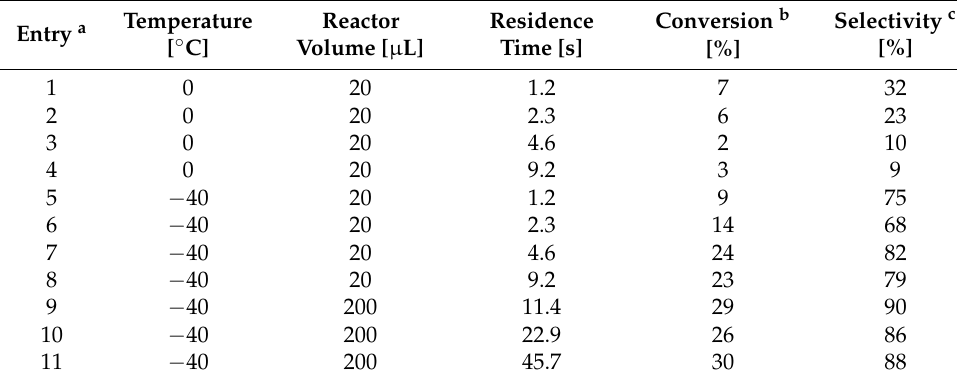
Table 1. Reduction using DIBAL-H in a constant diameter tube reactor (Reactor